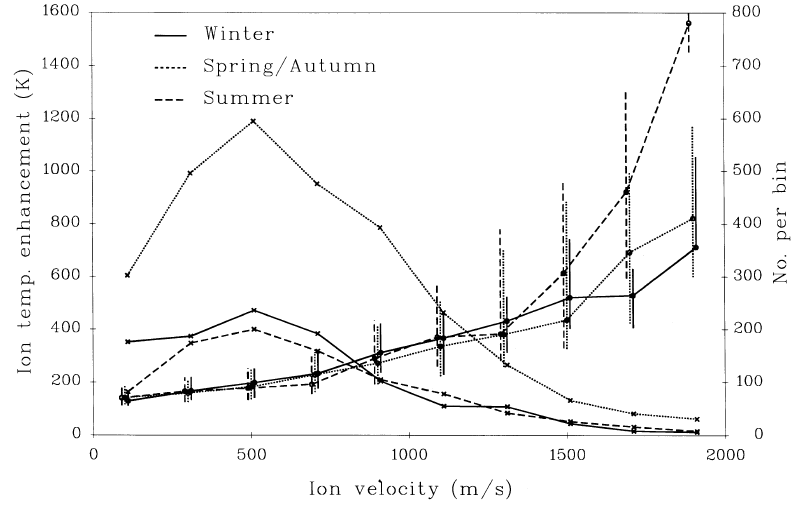
Fig. 7. Field-parallel ion temperature enhance- ment as a function of ion velocity during identified intervals of ion frictional heating. Indicated are the median enhancements in each 200 m s ) 1 width velocity bin for winter ( solid line ), the equinoctial seasons ( dotted line ) and summer ( dashed line ), with vertical lines which indicate the range bounded by the upper and lower quartiles. The number of estimates of parallel temperature enhancement in each veloc- ity bin are illustrated in corresponding line